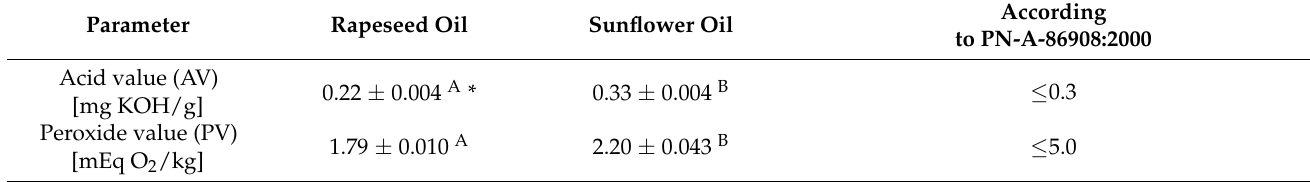
Table 3. Acid and peroxide values, and fatty acid profiles of rapeseed and sunflower